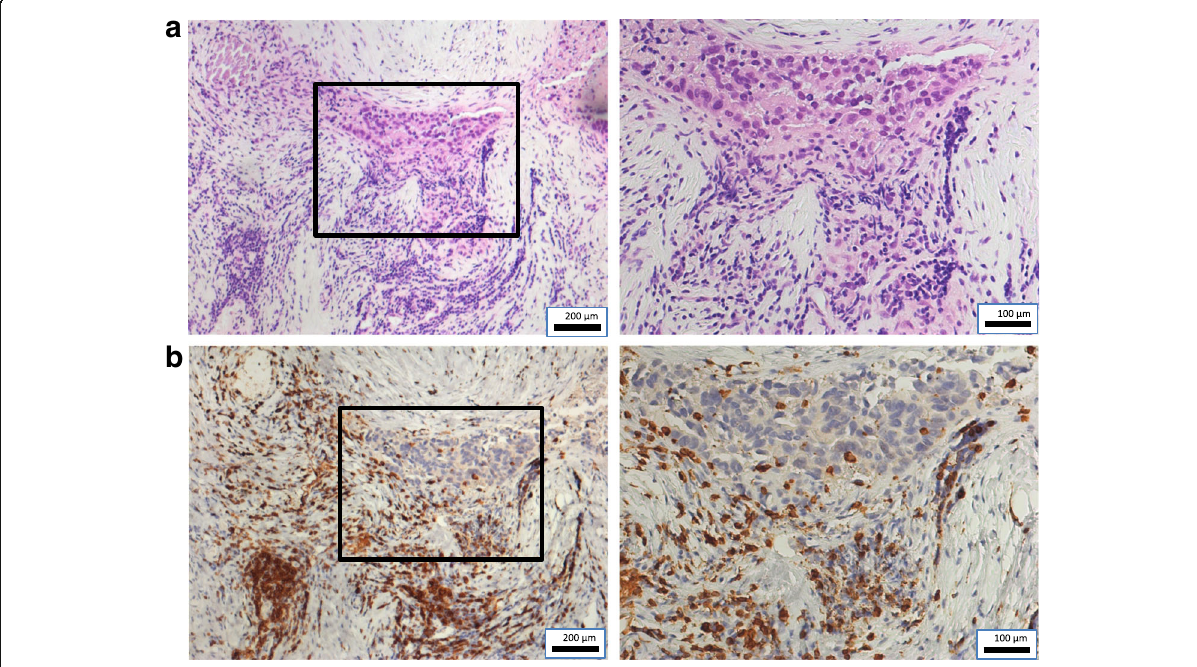
Fig. 5 Representative hematoxylin – eosin-stained images and CD3 + immunohistochemistry results in disseminated nodule specimen. a Tumor cells and tumor-infiltrating lymphocytes. Right: × 200; left (insert): × 100. b Rich lymphocytic infiltration around tumor cells. Brown chromogen: CD3 + T cells. Right: × 200; left (insert): ×